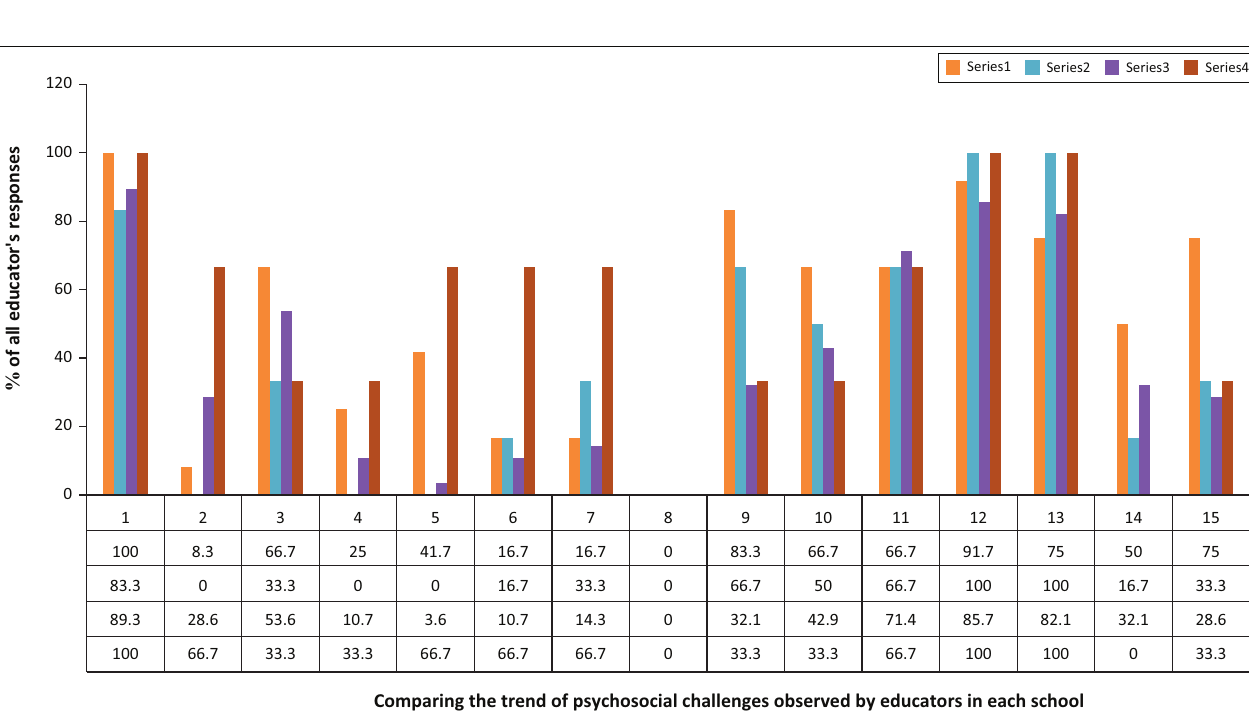
FIGURE 2: Comparing the psychosocial challenges observed ( % ) between Schools 1–4.